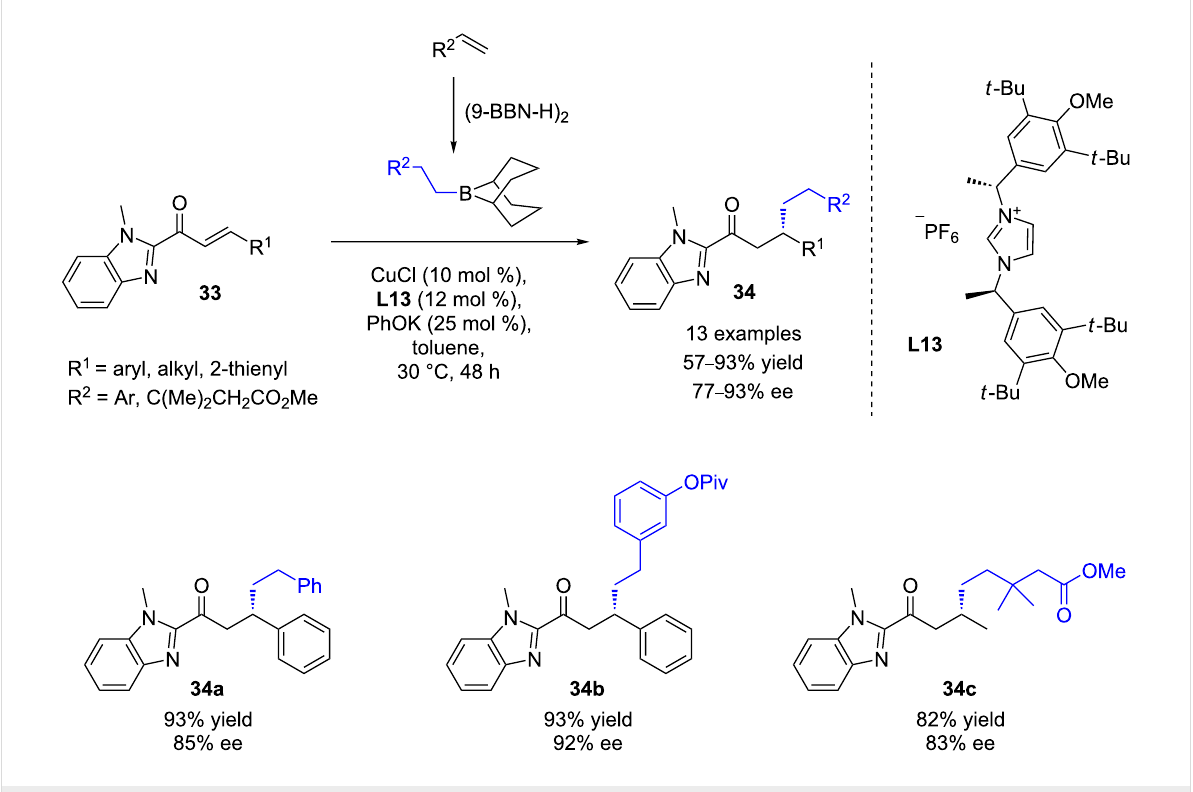
Scheme 15: Cu/ L13 -catalyzed ECA of alkylboranes to α , β -unsaturated